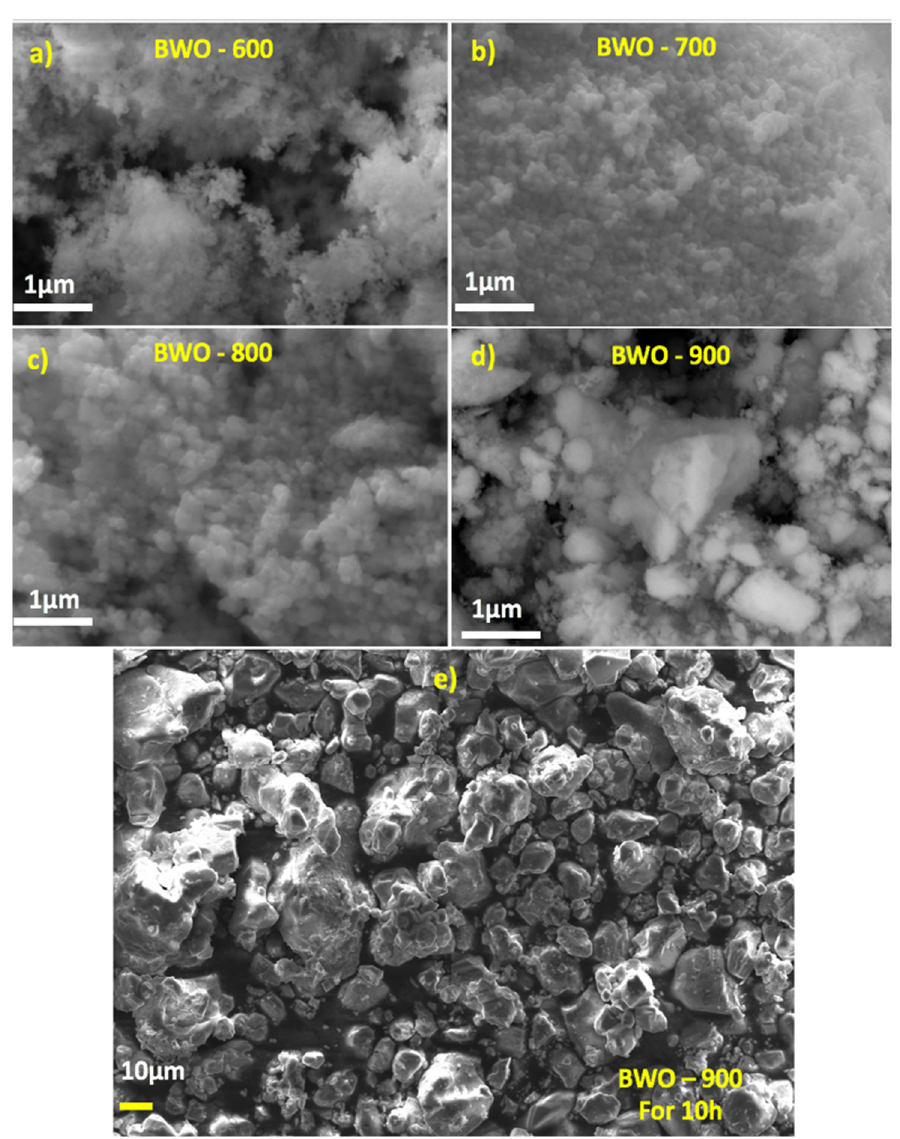
Figure 3. SEM micrographs of the prepared BWO at different temperatures.